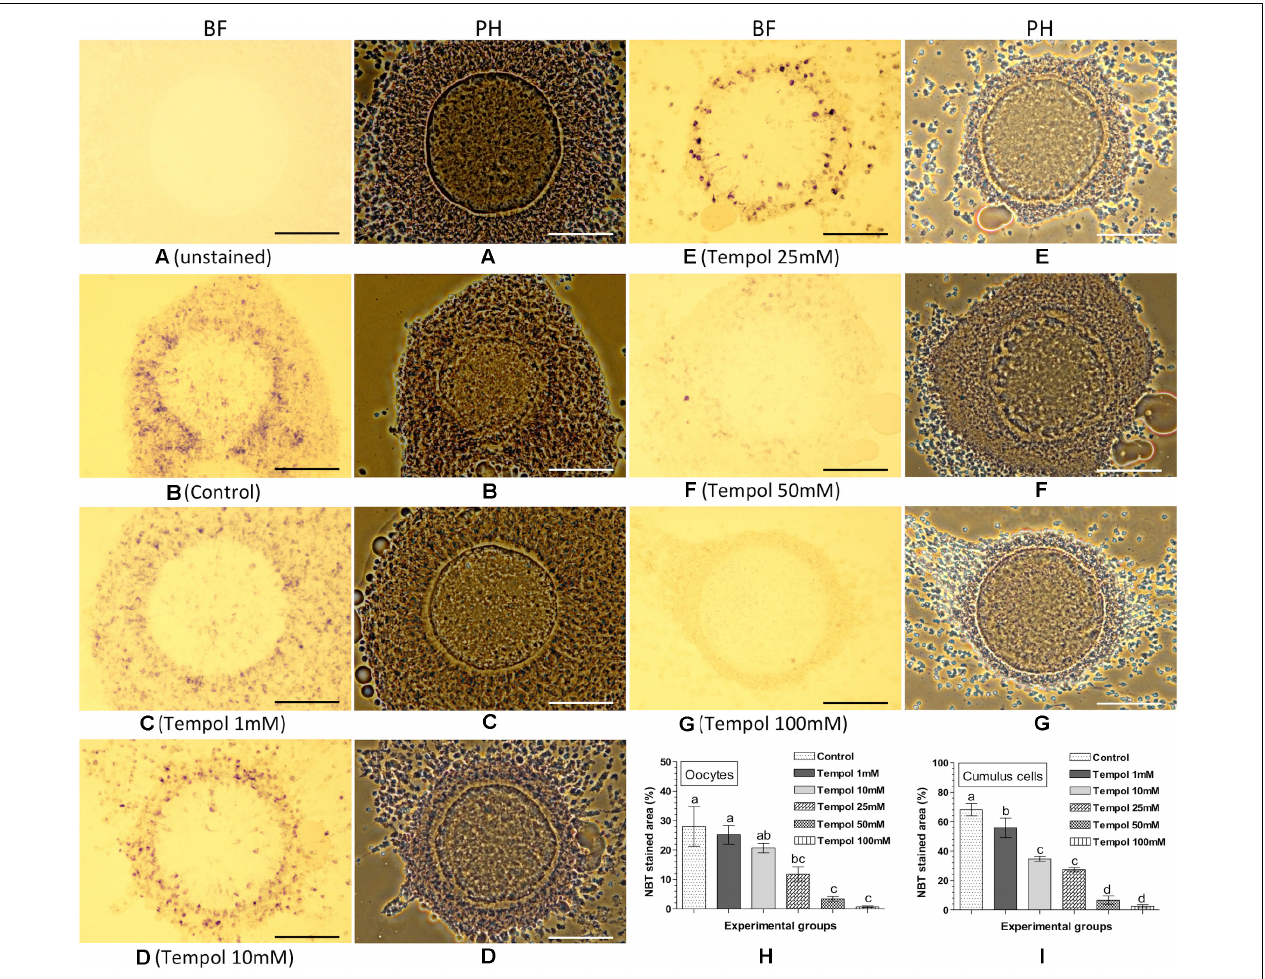
FIGURE 3 | Nitroblue tetrazolium (NBT) staining for assessing the effect of superoxide ion scavenger (Tempol) on intracellular ROS in oocytes and cumulus cells. Ovine cumulus-oocyte complexes (COC) were matured in vitro without (control) or with Tempol (1, 10, 25, 50, or 100 mM) supplementation and stained with NBT. The dark purple/blue spots of formazan precipitates represent ROS. The level of intracellular ROS (% NBT stained area, mean ± SE) was determined in oocytes and cumulus cells from five individual COC in each experimental group. (A) Unstained COC, control group; (B) NBT-stained COC, control group; (C–G) NBT-stained COC, Tempol supplemented groups; (H,I) level of intracellular ROS in oocytes and cumulus cells in different experimental groups. Values without a common superscript (a, b, c, d) above error bar differ significantly ( P < 0.05). BF, bright-field image; PH, phase-contrast image. Scale bar = 100 µ